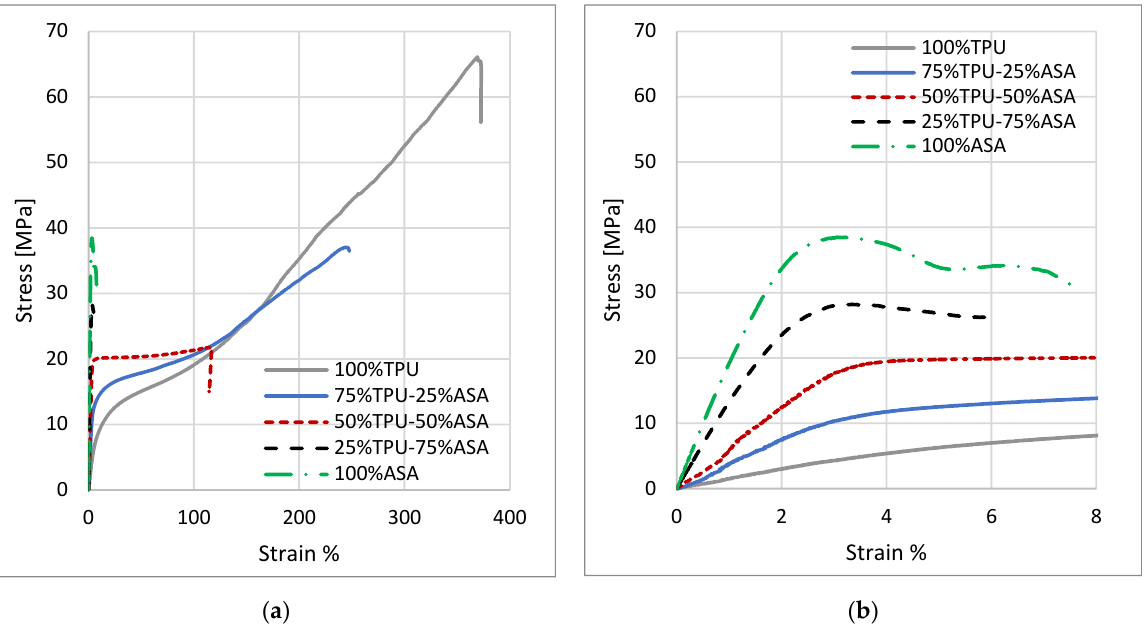
Figure 15. ( a ) Stress – strain curves for the different ASA-TPU mixes. ( b ) Enlargement of the stress – strain curves at low deformation percentages.